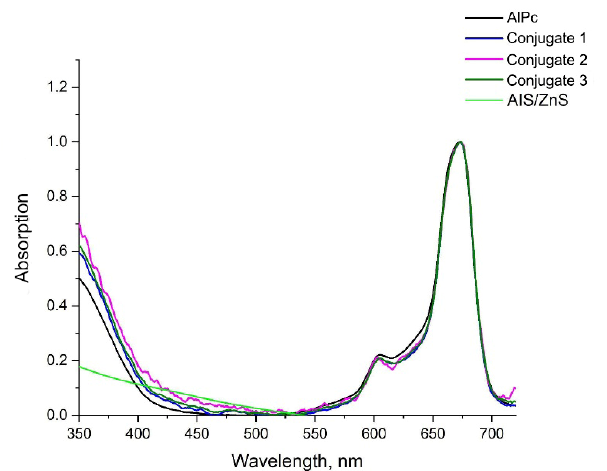
Figure 5. Absorption spectra of the studied samples, normalized to the maximum ( λ = 660 nm). The samples were dissolved in distilled water. The molar concentration of QDs in three conjugates was 33 μ M. The molar concentration of AlPc in conjugate 1 and 3 was 20.4 μ M, in conjugate 2 was 10.2 μ M.